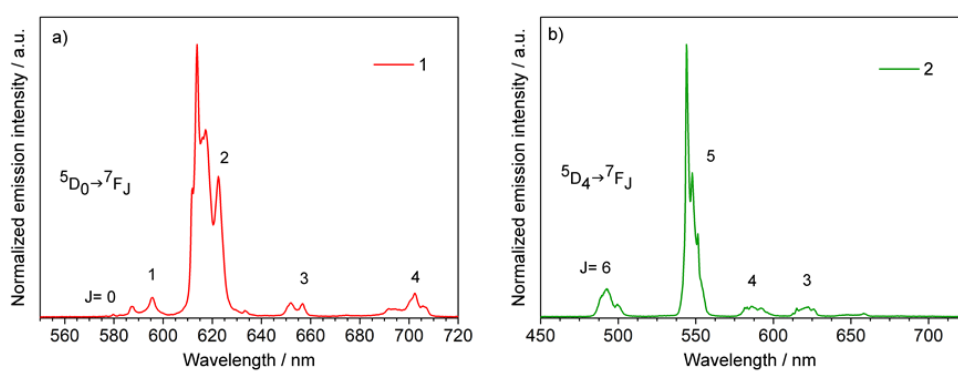
Figure 3. Emission spectra of compounds ( a ) 1 and ( b ) 2 . λ exc = 320